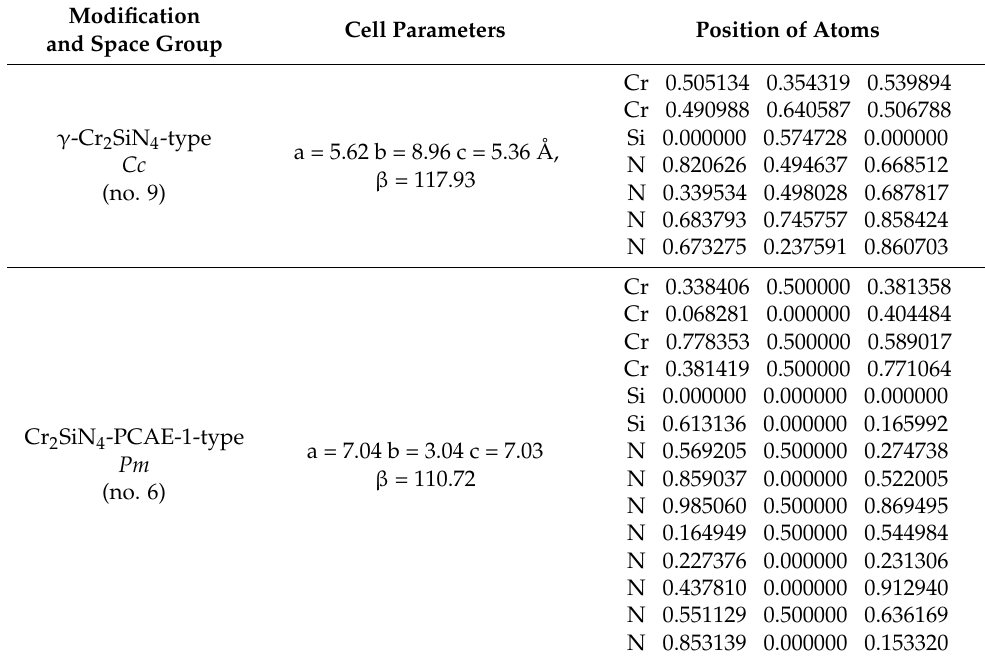
Table 7. The modifications, space groups, unit cell parameters, and atomic positions for favorable Cr 2 SiN 4 modifications found using the PCAE method and the GGA-PBE